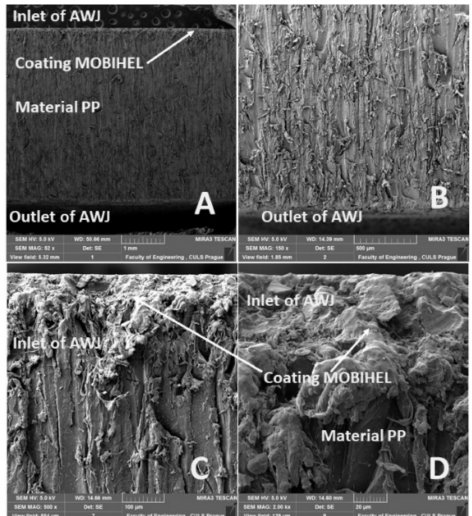
Figure 20. View of the cut of the tested PP + MOBIHEL, AWJ technology, cutting head traverse speed 50 mm · min − 1 : ( A ) overall cut (MAG 52 × ); ( B ) detailed view of the outlet of AWJ (MAG 150 × ); ( C ) detailed view of the inlet of AWJ (MAG 500 × ); ( D ) detailed view of the interface of MOBIHEL coating and PP material (2000 × ).